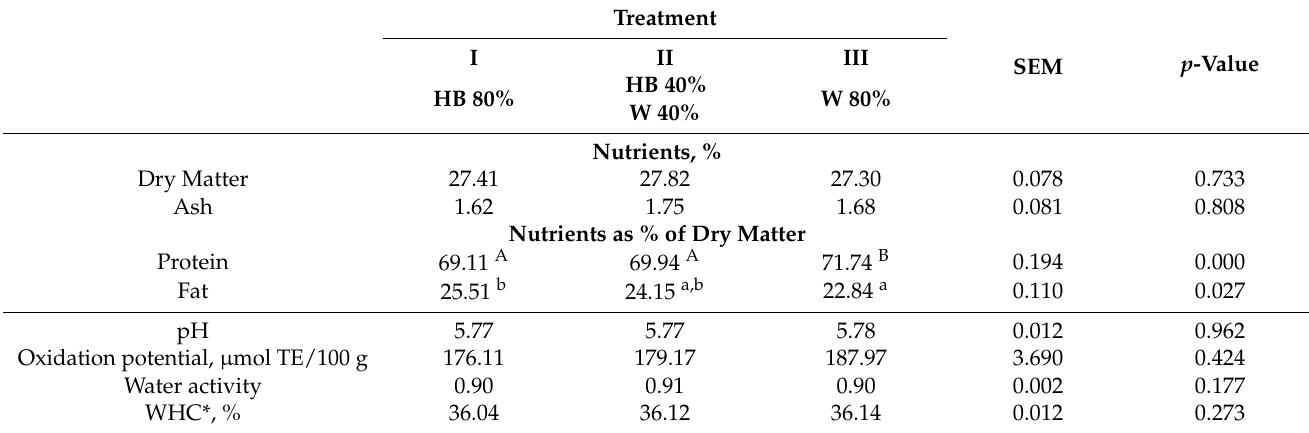
Table 1. Physicochemical characteristics of meat (loin).